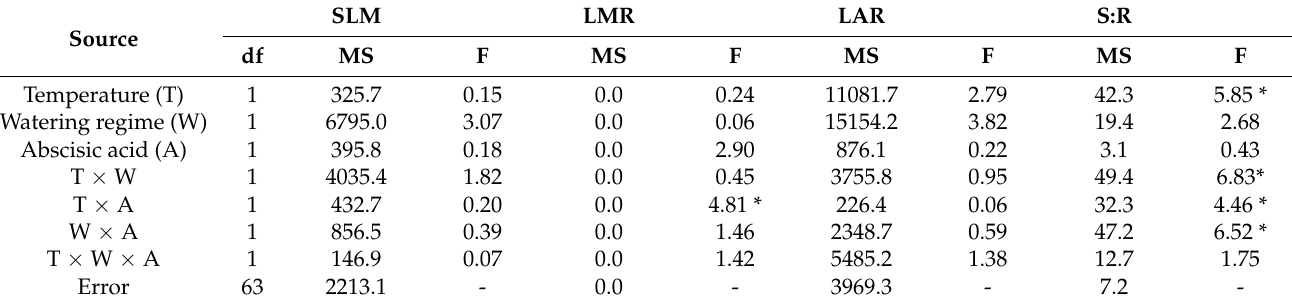
Table 7. Analysis of variance for the effects of temperature, watering regime, abscisic acid, and their interactions on growth indices of tomato